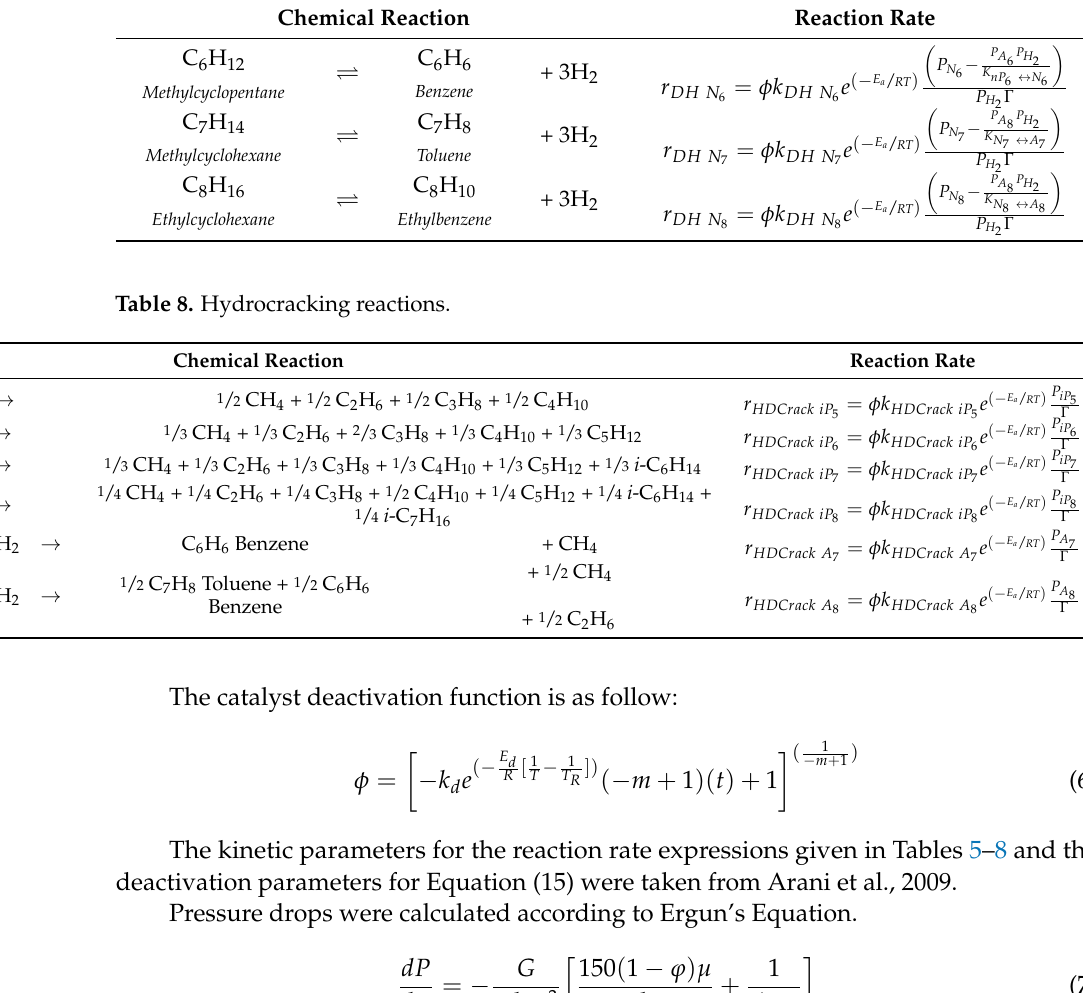
Table 7. Dehydrogenation of naphthenes. Chemical Reaction